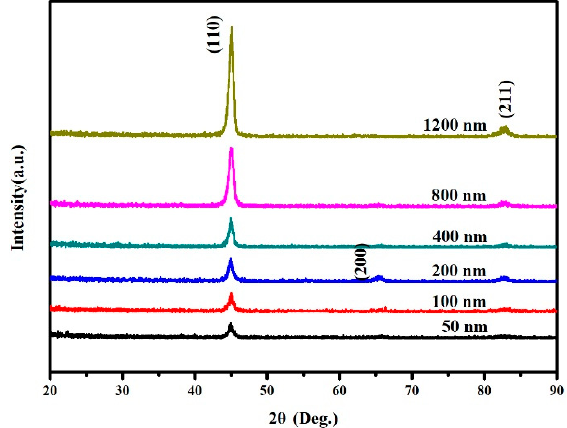
Figure 2. GI-XRD patterns for FeCo thin films with different thickness.